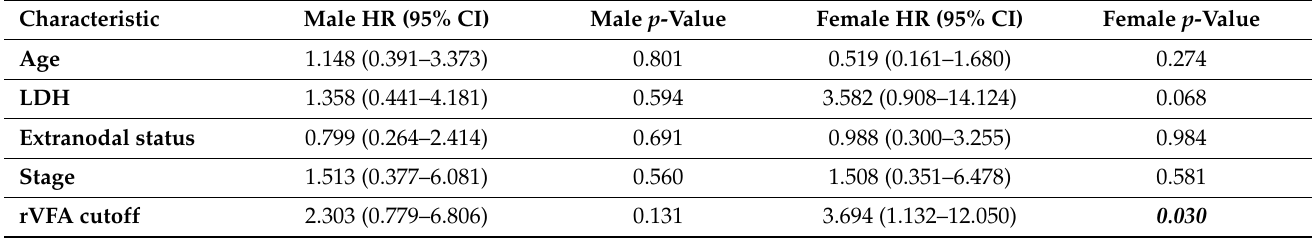
Table 3. Overall Survival (OS) multivariate Cox regression analysis for rVFA.